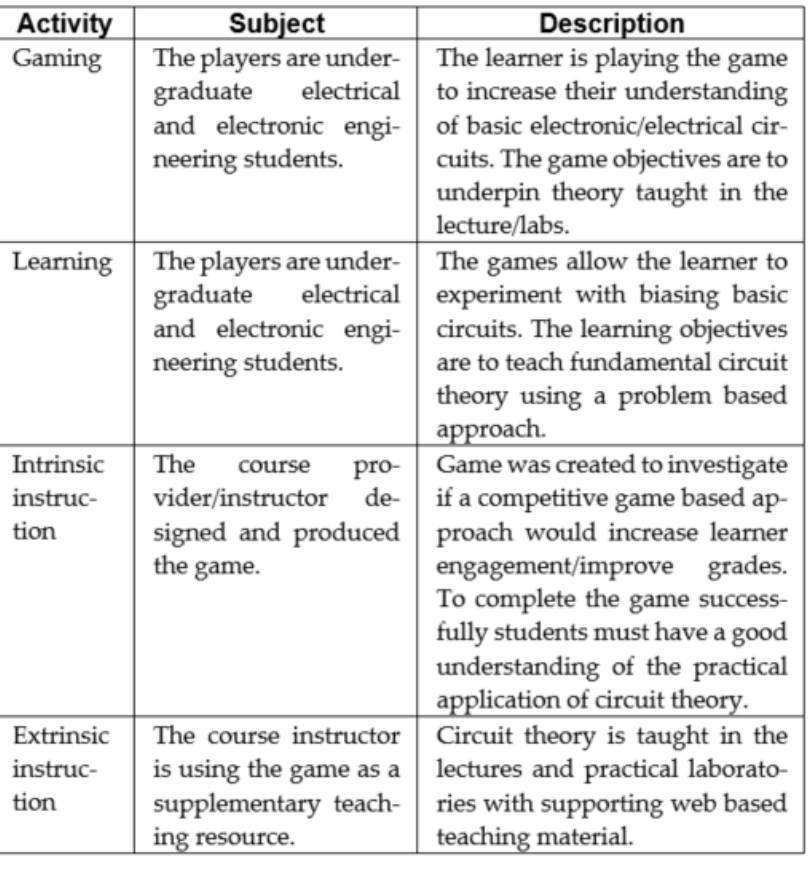
Table 1. Initial analysis to identify activities